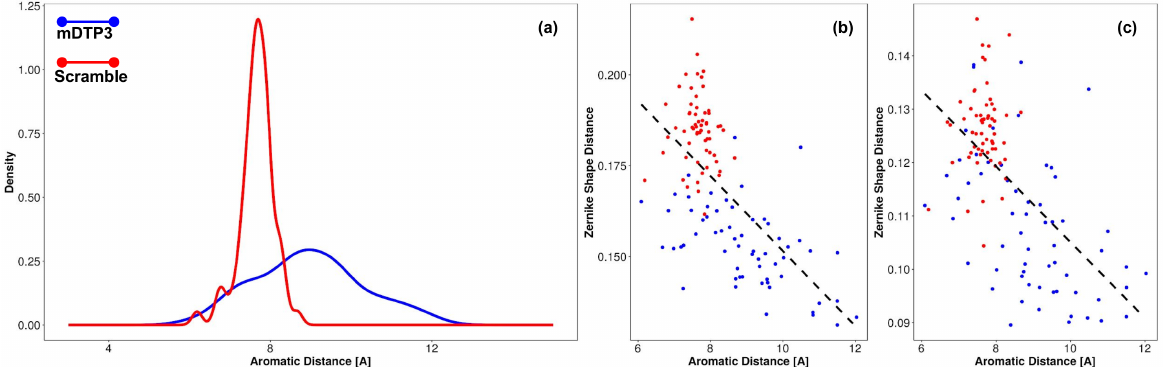
Figure 7. ( a ) Distribution of spatial distances between side chain heavy atoms geometrical center of aromatic residues of DTP3 and SCRB peptides. ( b , c ) Correlation of the distances explored by the peptides with shape complementarity to the binding pockets BP3 and BP4,